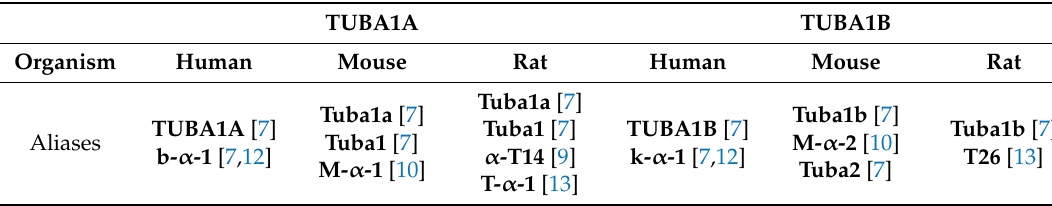
Table 1. α -tubulin protein isotype